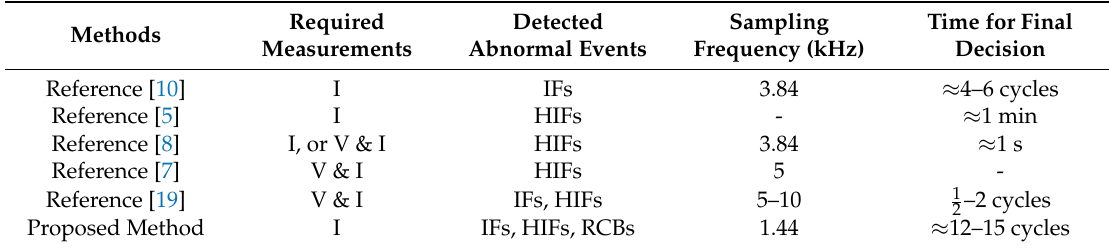
Table 6. Comparison between different methods and their